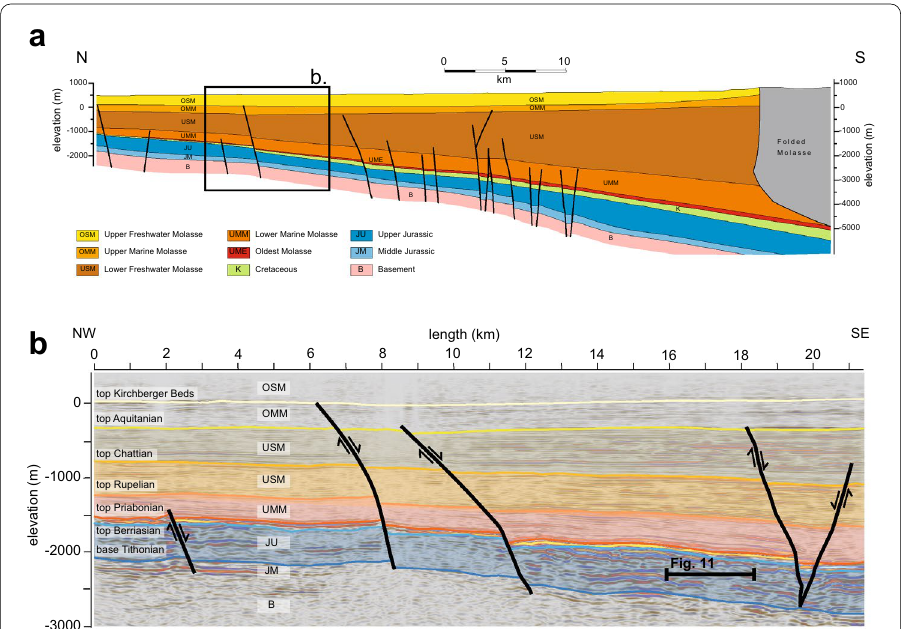
Fig. 2 Geological cross sections. a Geological N–S cross section through the Bavarian Molasse Basin, east of Munich (redrawn after GeoMol 2015), showing the general downdip to the south, and faults due to lithospheric bending setting. Black rectangle is the section shown in b. b Interpreted seismic P-wave section through the 3D volume, showing that the reservoir (blue; Top Berriasian–base Tithonian) dips to the south and is cut by normal faults. The location of the Fig. 11 is shown. Locations of both sections are shown in Fig.